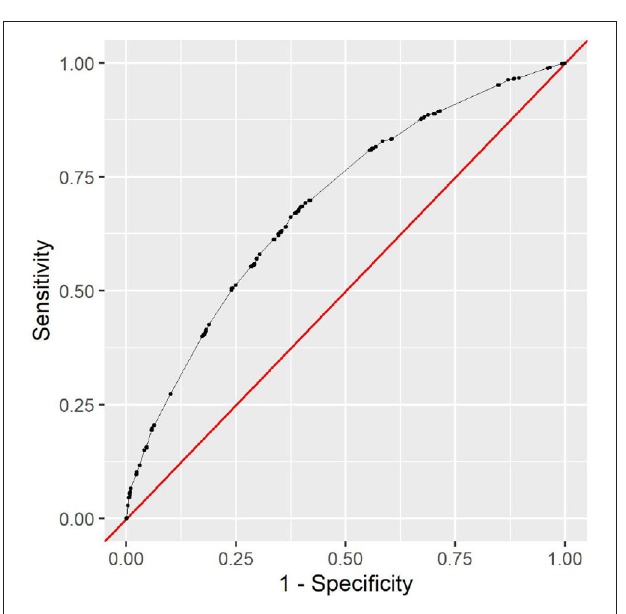
FIGURE 6 | The receiver operating characteristic of the full model.